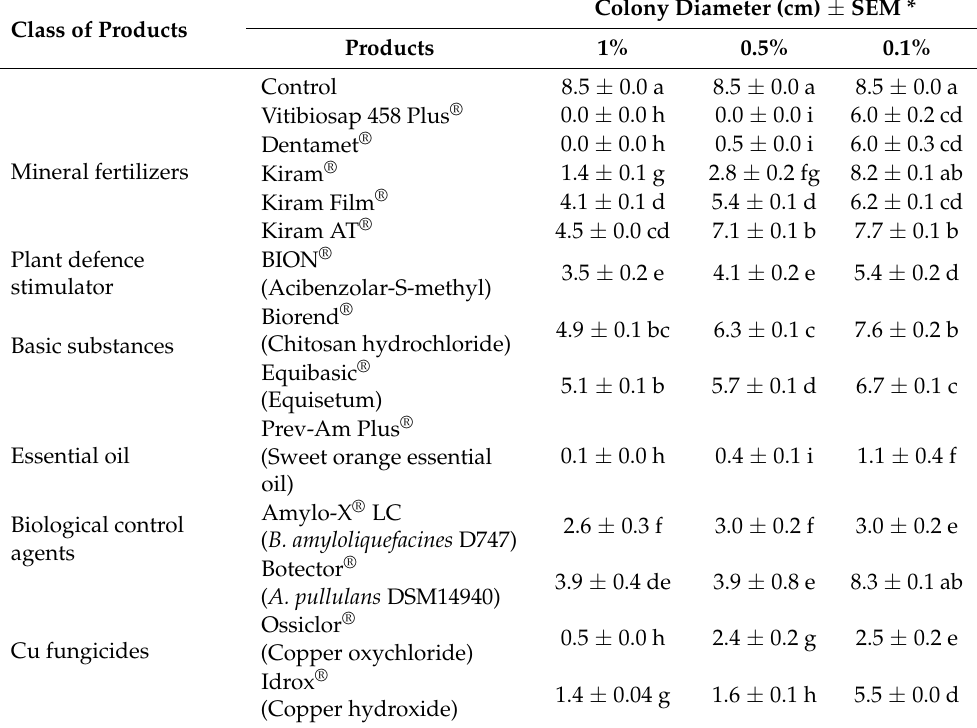
Table 1. Colletotrichum gloeosporioides colony diameter (cm) on PDA medium amended with different potential fungicides at different concentrations (1%, 0.5%, 0.1%). Plates were incubated at 25 ± 1 ◦